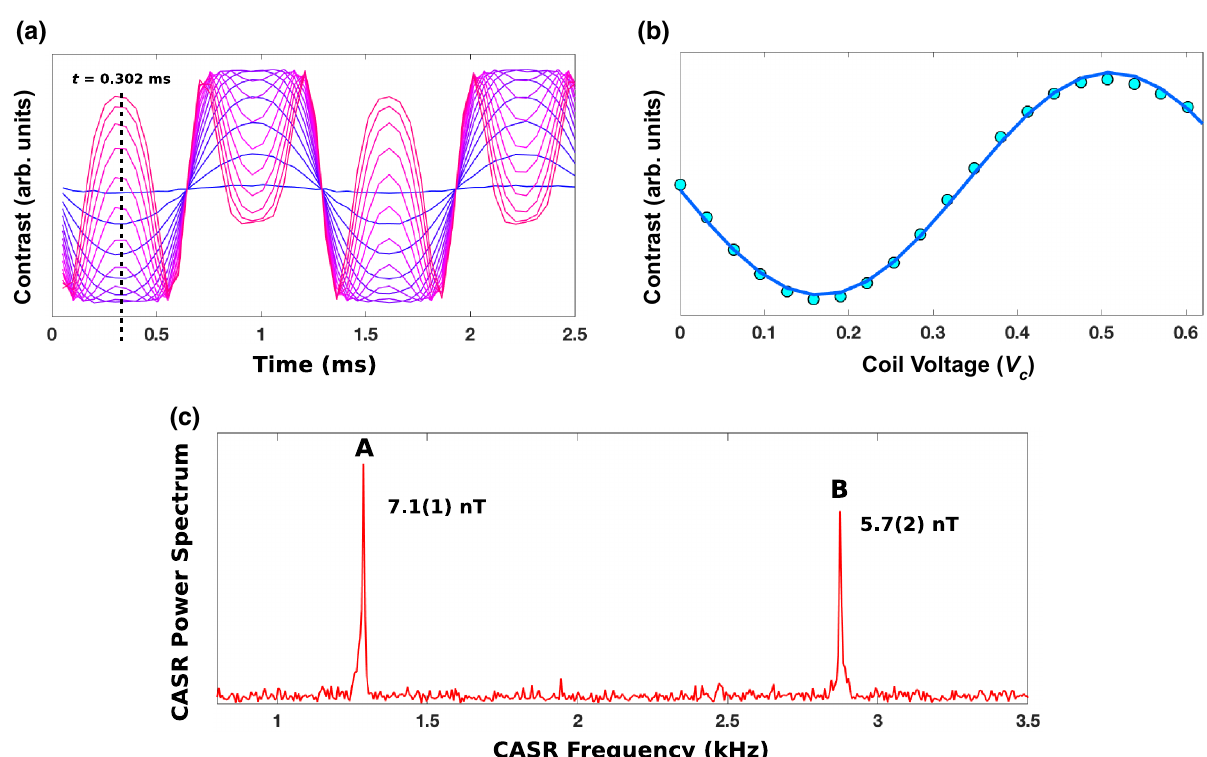
FIG. 10. (a) CASR NV measurements of the ac magnetic test signals from a nearby coil at f coil = 280 kHz. The coil drive voltage V c for the ac signal source of the coil is varied from V c = 0 (purple trace) to V c = 0.6 V (magenta trace). (b) CASR signal data (blue points) as a function of coil voltage V c at time t = 0.302 ms, obtained along the dashed line in (a). The blue line is a sinusoidal fit to the data, which gives the magnetic test signal calibration of 5.7(2) μ T / V. (c) CASR-detected NV-NMR spectra (peak A) of pyridine and test signal (peak